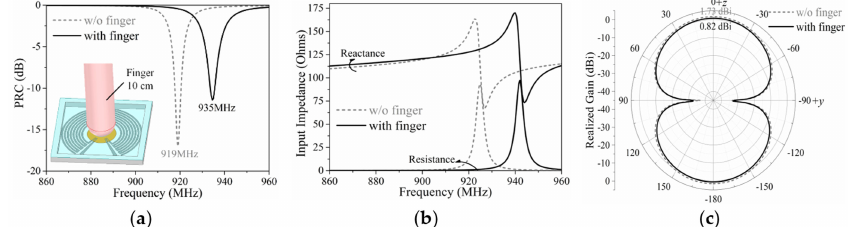
Figure 8. Simulated ( a ) PRC, ( b ) input impedance, and ( c ) radiation pattern results of the optimized proposed RFID tag with / without the impact of the finger.